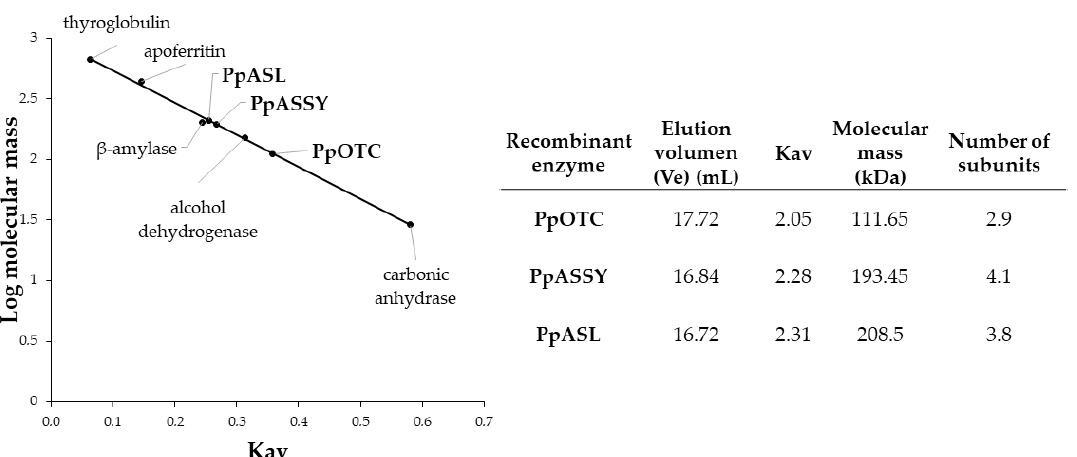
Figure 3. Molecular mass estimations of PpOTC, PpASSY and PpASL. Samples from purified proteins were loaded separately onto a size exclusion ENrich™ SEC 650 column (Bio-Rad). Molecular masses were calculated by comparing the partition coefficient (Kav) of the samples with the standards used to calibrate the column: thyroglobulin (669 kDa), apoferritin (443 kDa), β -amylase (200 kDa), alcohol dehydrogenase (150 kDa) and carbonic anhydrase (29 kDa).